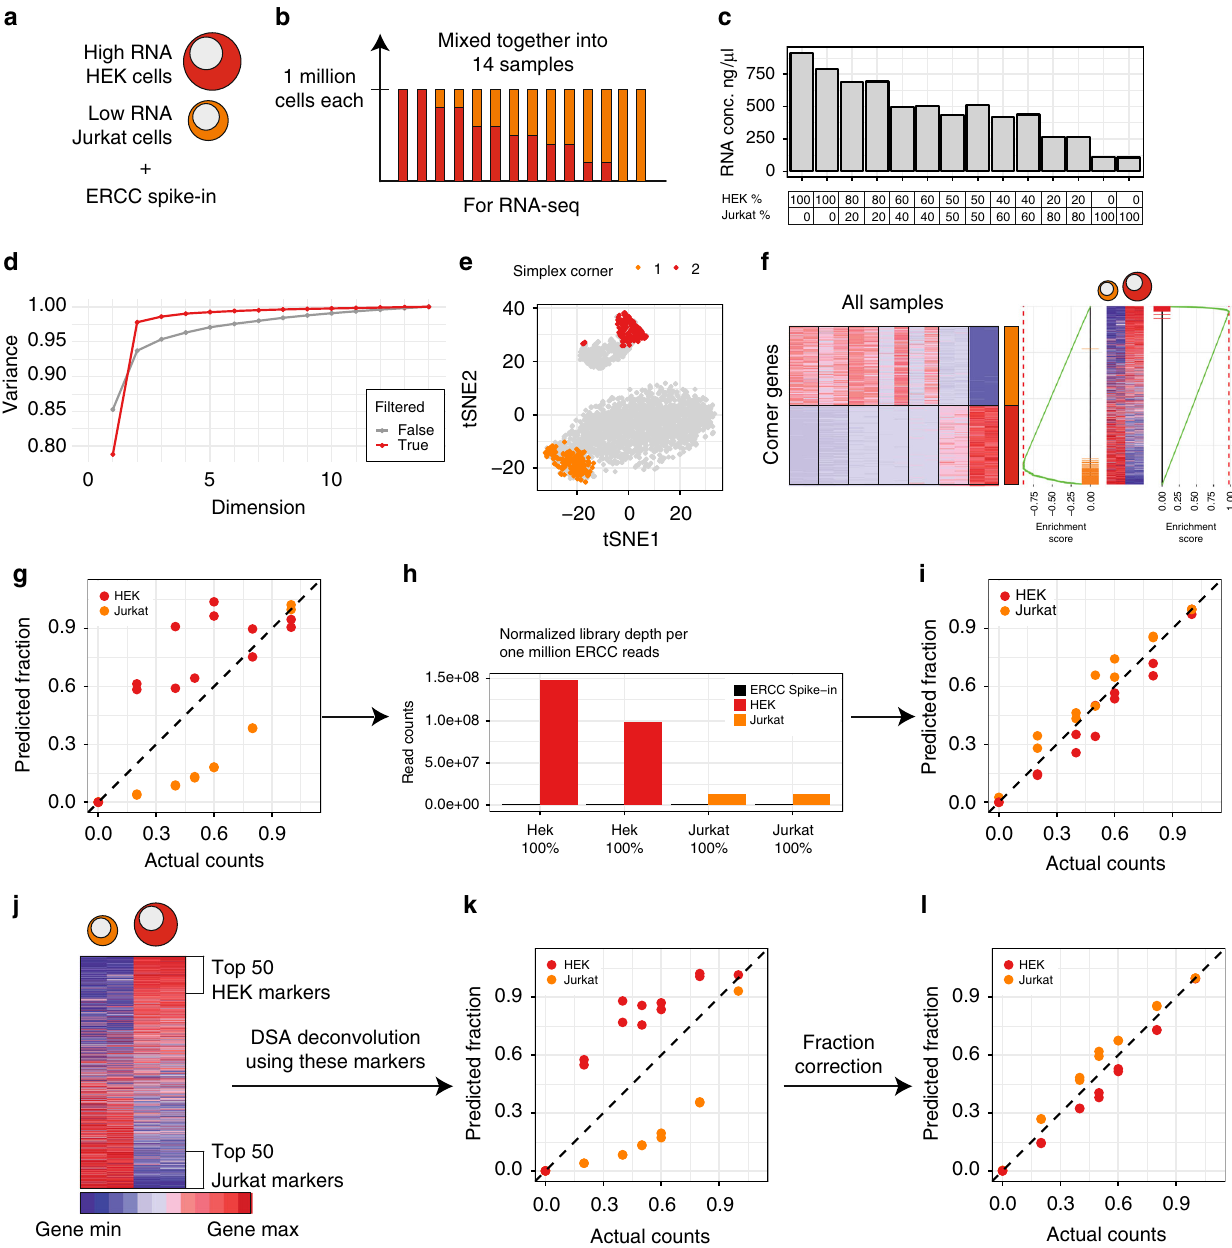
Fig. 8 Systematic error is caused by difference in cell size/cellular RNA content. Experiment schematic: a cell types that were chosen for the experiment, b proportions of the cell type for the experiment. c RNA content for each sequenced sample. d Explained variance by SVD for fi ltered and un fi ltered datasets. Closest 100 genes to each simplex corner were selected to identify cell types. e TSNE plot for the fi ltered dataset: two clusters can be visually identi fi ed. Colored genes are those from the corners. f Gene expression pro fi les of selected genes in mixed samples and GSEA comparing these genes to differential expression between pure samples of HEK and Jurkat cells. g Proportions predicted by the pipeline. h Bar plot showing relative RNA content to ERCC-spike-in. i Corrected proportions of the pipeline. j Usual pipeline for complete deconvolution: we detect the markers using differential expression and use these markers as input of DSA algorithm. k Proportions predicted by DSA using differential expression markers. l Corrected proportions of